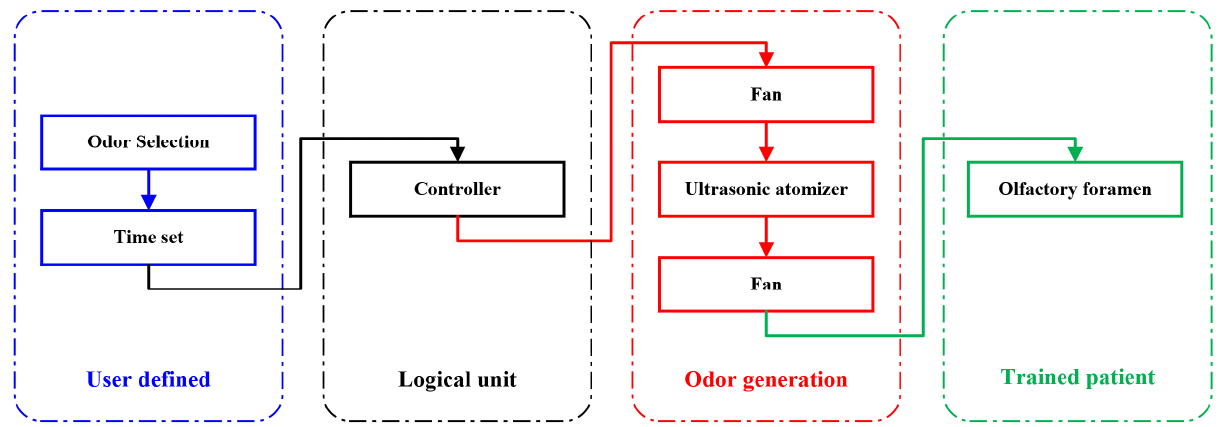
Figure 8. Workflow for olfactory training by the developed device.